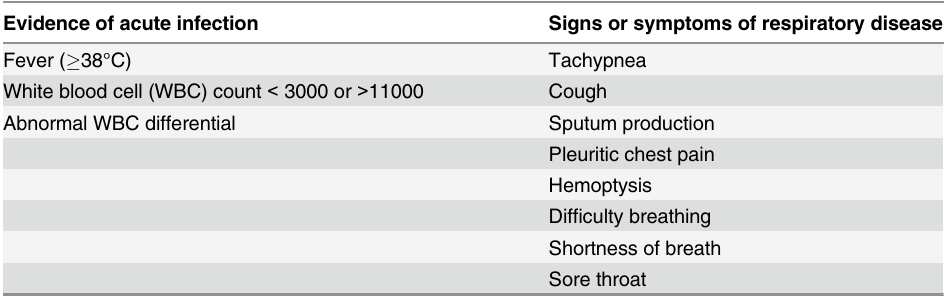
Table 1. Acute Respiratory Infection Case Definition *